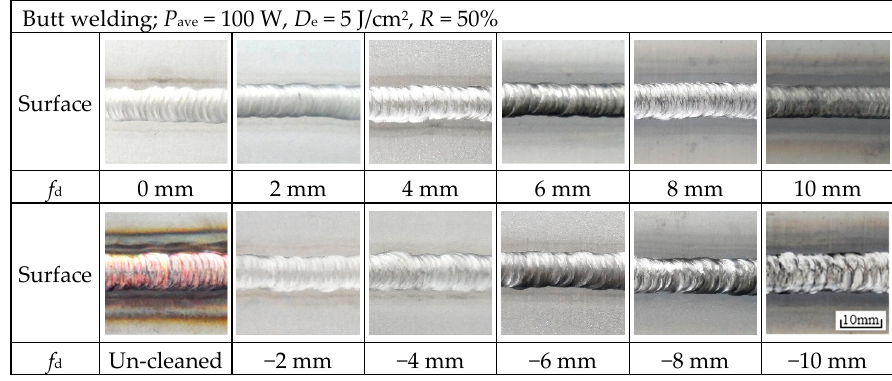
Figure 6. Photos of the laser cleaned surface according to defocus distance.